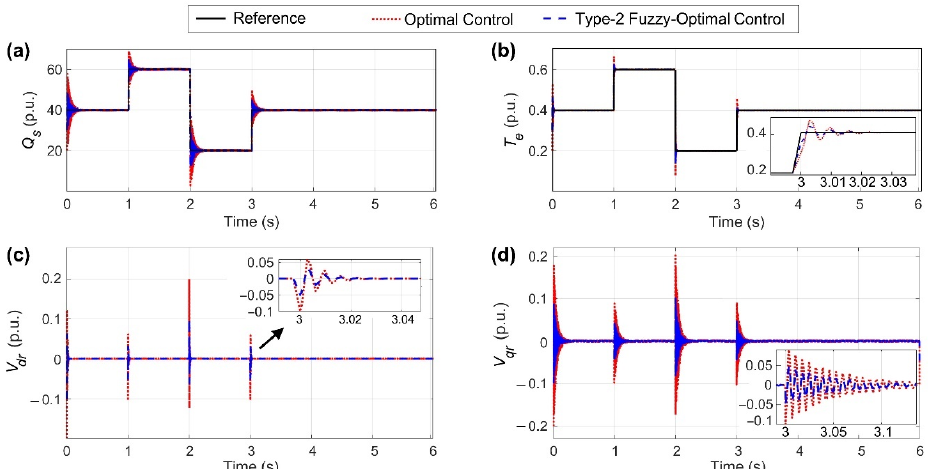
Figure 7. The shapes of ( a – d ) are related to the stator reactive power and electromagnetic torque tracking performance and created control signals by optimal control (with and without the type-2 fuzzy system).